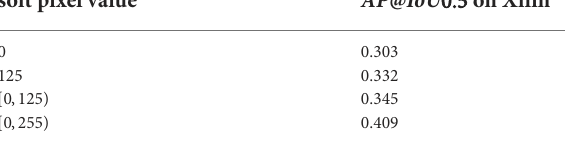
TABLE 2 Performances of our approach with different soft